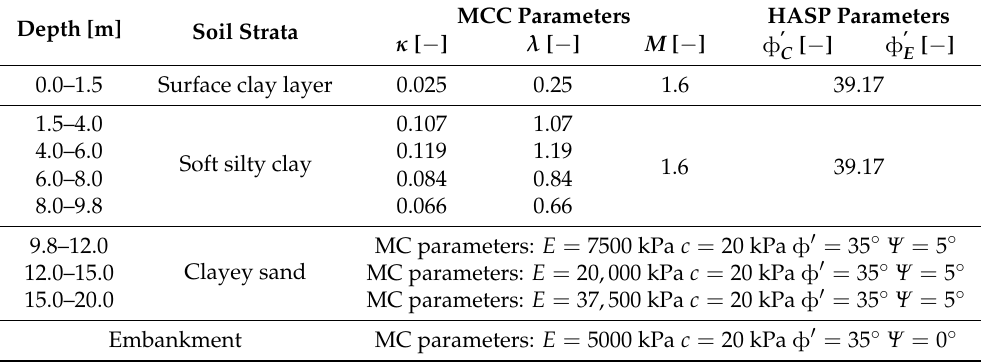
Table 3. Soil model parameters for Embankment